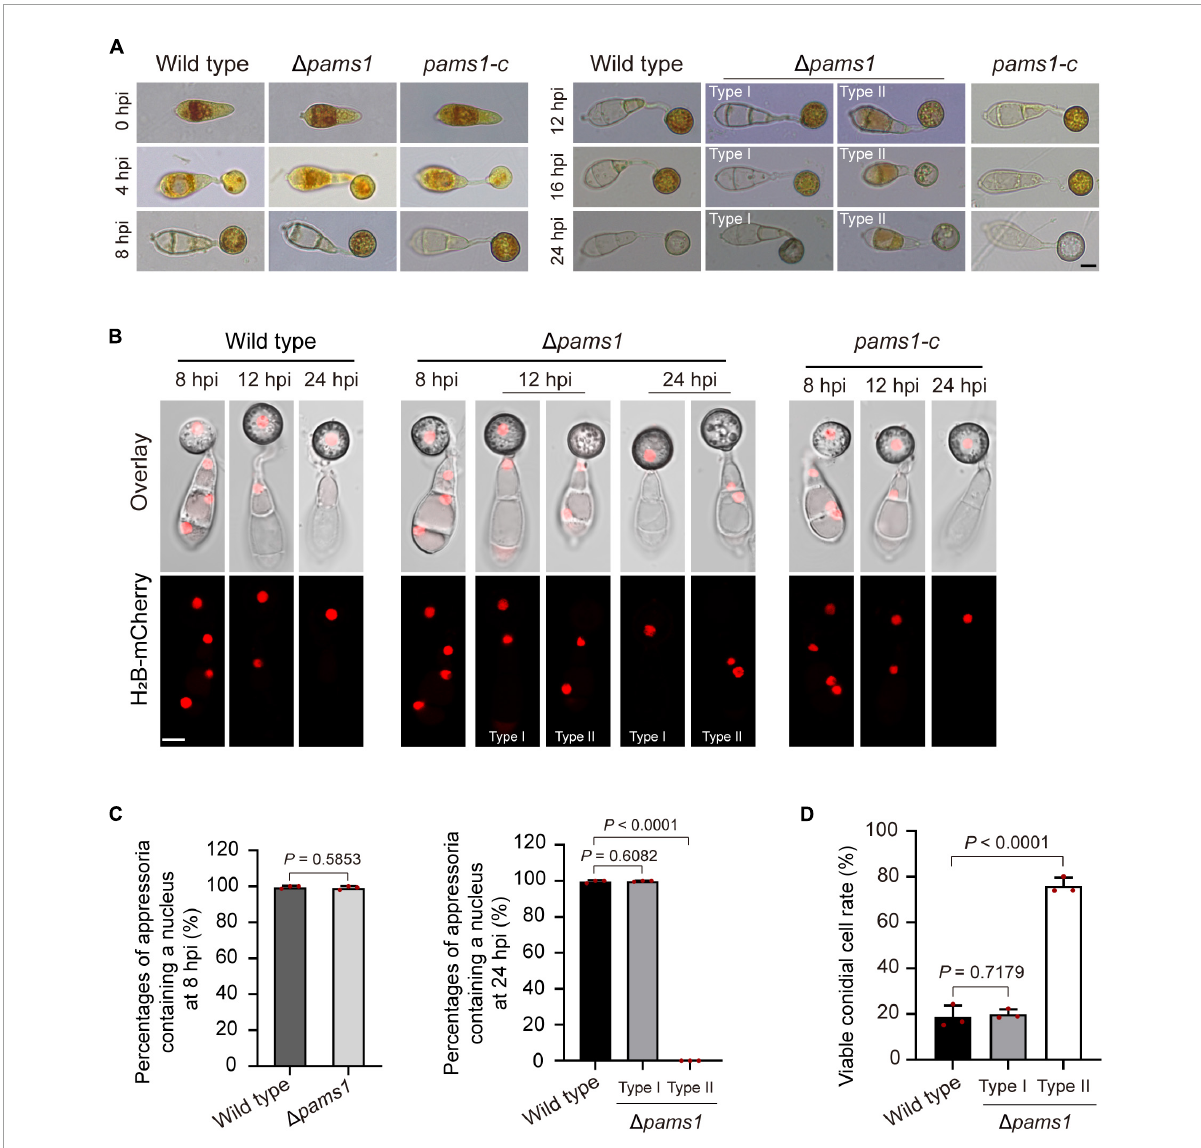
FIGURE8 Glycogen granules and nuclei in (cid:49) pams1 ’s appressoria and viable conidial cells in spores that formed appressoria. (A) Distributions of glycogen granules in spores and appressoria at 0, 4, 8, 12, 16, and 24 hpi. Glycogen granules were stained by KI/I 2 solution. Glycogen granules in spore cells that formed type II abnormal appressoria were not fully mobilized into appressoria at 24 hpi. (B) Distribution of H 2 B-mCherry-marked nuclei in appressoria of the wild type, complementation strain pams1-c , and (cid:49) pams1 (types I and II abnormal appressoria) at 8, 12, and 24 hpi. (A,B) Scale bars, 5 µ m. (C) Percentages of appressoria containing a nucleus at 8 and 24 hpi ( n = 3). At least 150 appressoria were counted per replicate. (D) Percentages of viable conidial cells in spores that formed appressoria at 24 hpi ( n = 3). The spores were inoculated on plastic coverslips for 24 hpi and stained with FDA. At least 240 conidial cells were counted per